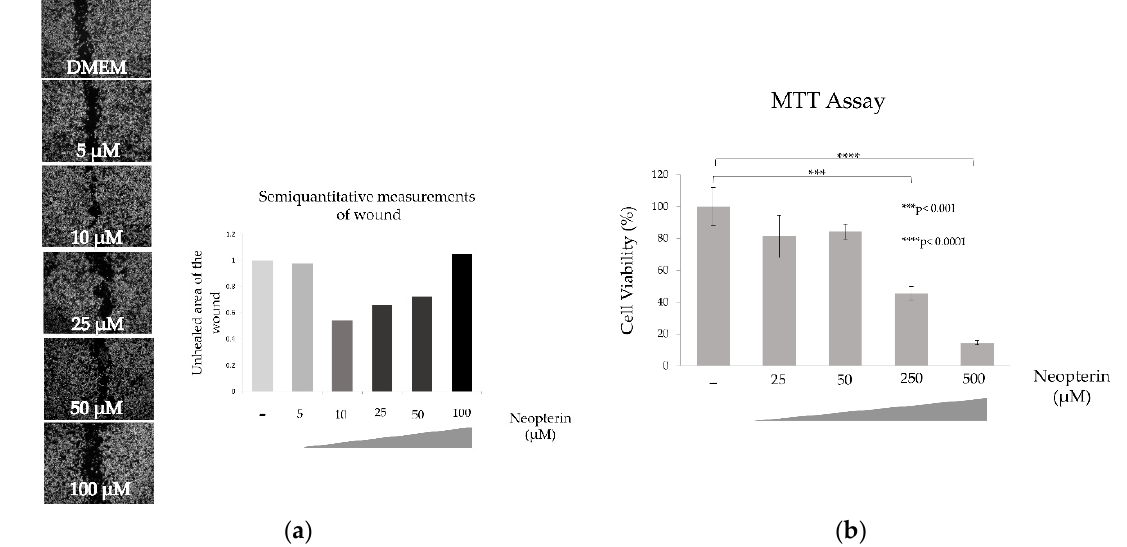
Figure 5. Effect of neopterin on wound healing ( a ) and cytotoxicity ( b ) of SK-HEP-1 cell